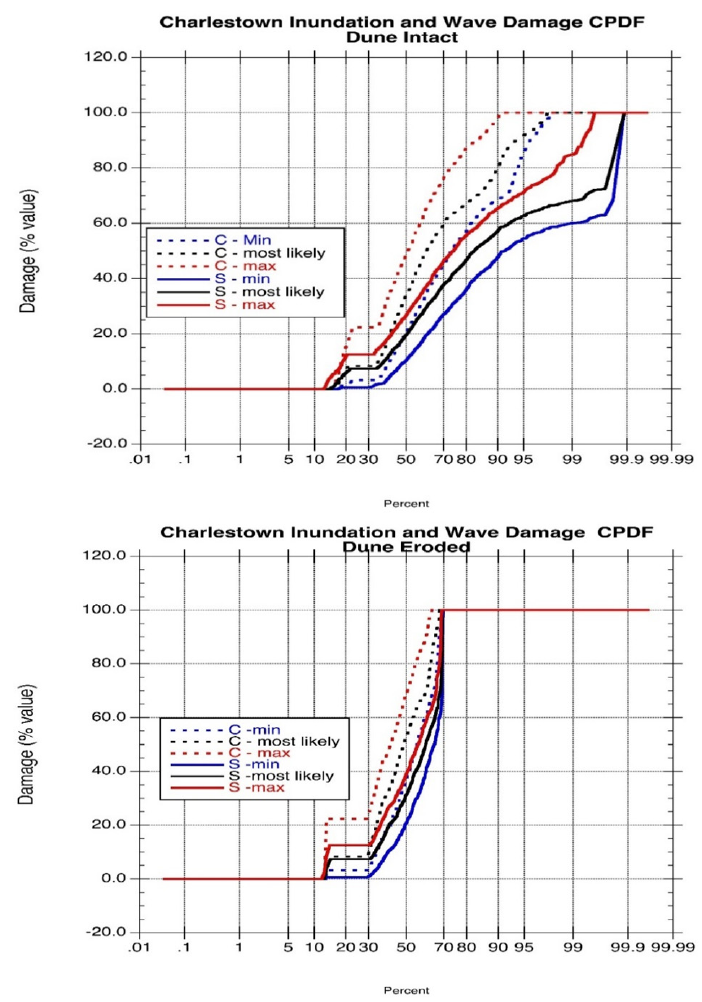
Figure 11. Cumulative structure and content damage curves for Charlestown, RI, 100 year, dunes intact (top panel) and dunes eroded (lower panel). Content damage (C) is shown by the dashed lines and structural damage (S) by the solid lines. Results are shown for the minimum, most likely, and maximum damage function curves [5]. Table 3. Number of structures damaged for the Charlestown, RI study area for various scenarios. Damages are based on the most likely curve. Upper panel shows all structures damaged while lower panel shows structures that are more than 50% damaged.